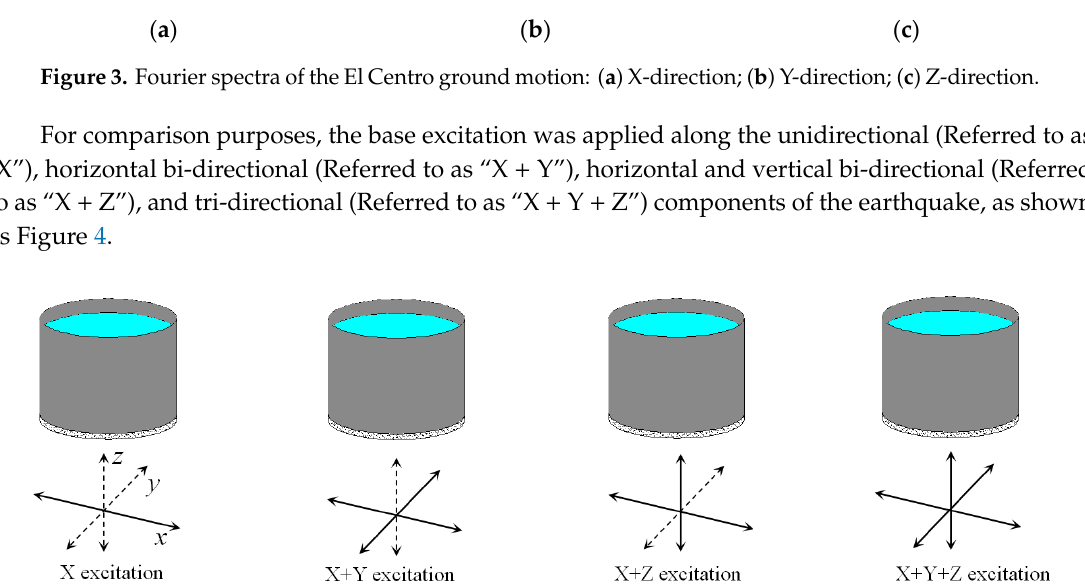
Figure 4. A schematic diagram of the four calculation conditions (the dotted line on the axis indicates that there is no excitation in this direction).